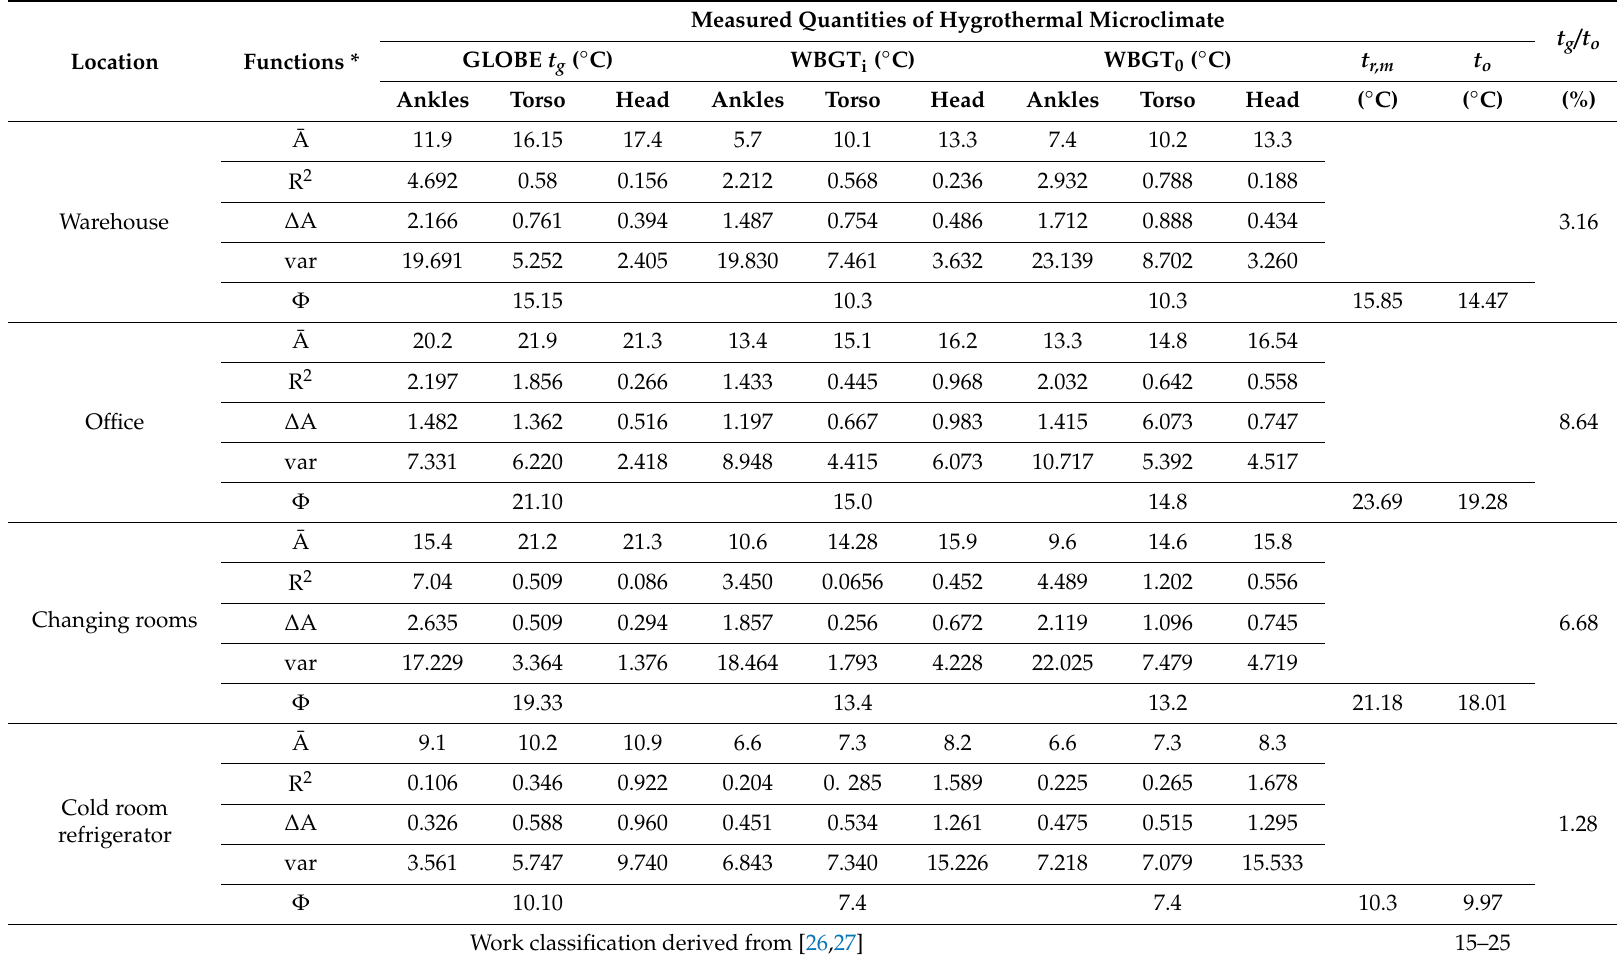
Table 2. Statistical evaluation of the average measured values of microclimatic conditions in the food storage